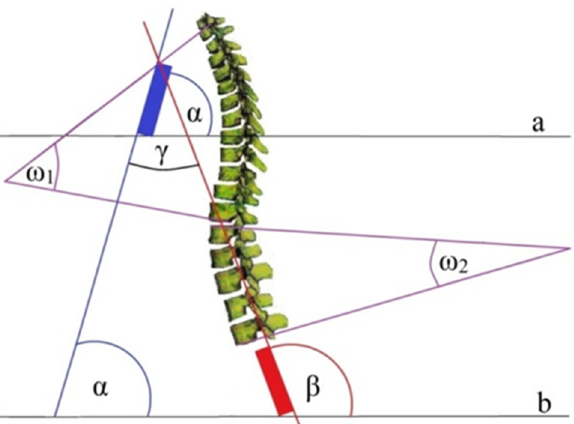
Figure 4. The common system of the position of the sternal body and the sacrum in relation to thoracic kyphosis and lumbar lordosis [30].